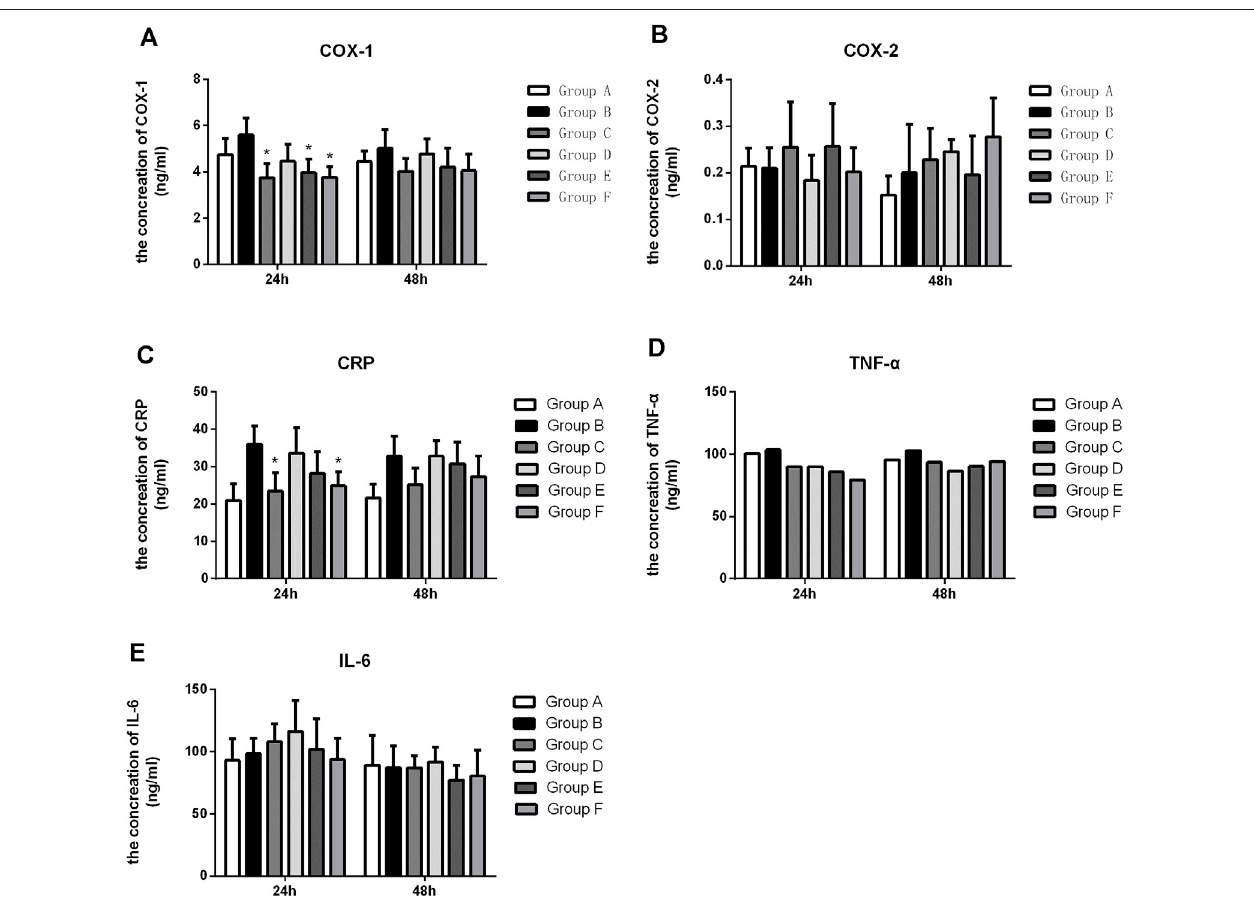
FIGURE4| ThelevelofCOX-1,COX-2,CRP,TNF- α andIL-6intheserumaftertreatmentwith fl urbiprofenestermicrospheresbydifferentdeliverysystem. (A) The level of COX-1 in the serum by different treatment of fl urbiprofen ester microspheres; (B) the level of COX-2 in the serum by different treatment of fl urbiprofen ester microspheres; (C) The level of CRP in the serum by different treatment of fl urbiprofen ester microspheres; (D) The level of TNF- α in the serum by different treatment of fl urbiprofen ester microspheres; (E) The level of IL-6 in the serum by different treatment of Flurbiprofen ester microspheres, * p < 0.05.